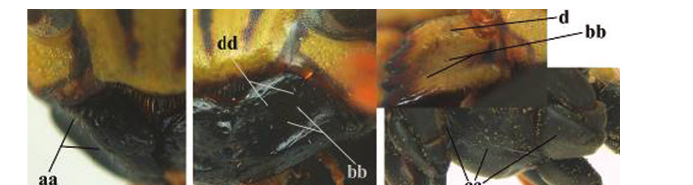
– Basal half of mandible straight in dorsal view or nearly so (aa); mandibular depression shallowly concave (bb); [fore and middle coxae and mesopleuron ventrally usually black (cc), colour of mandible variable (d, dd)] ............... 23